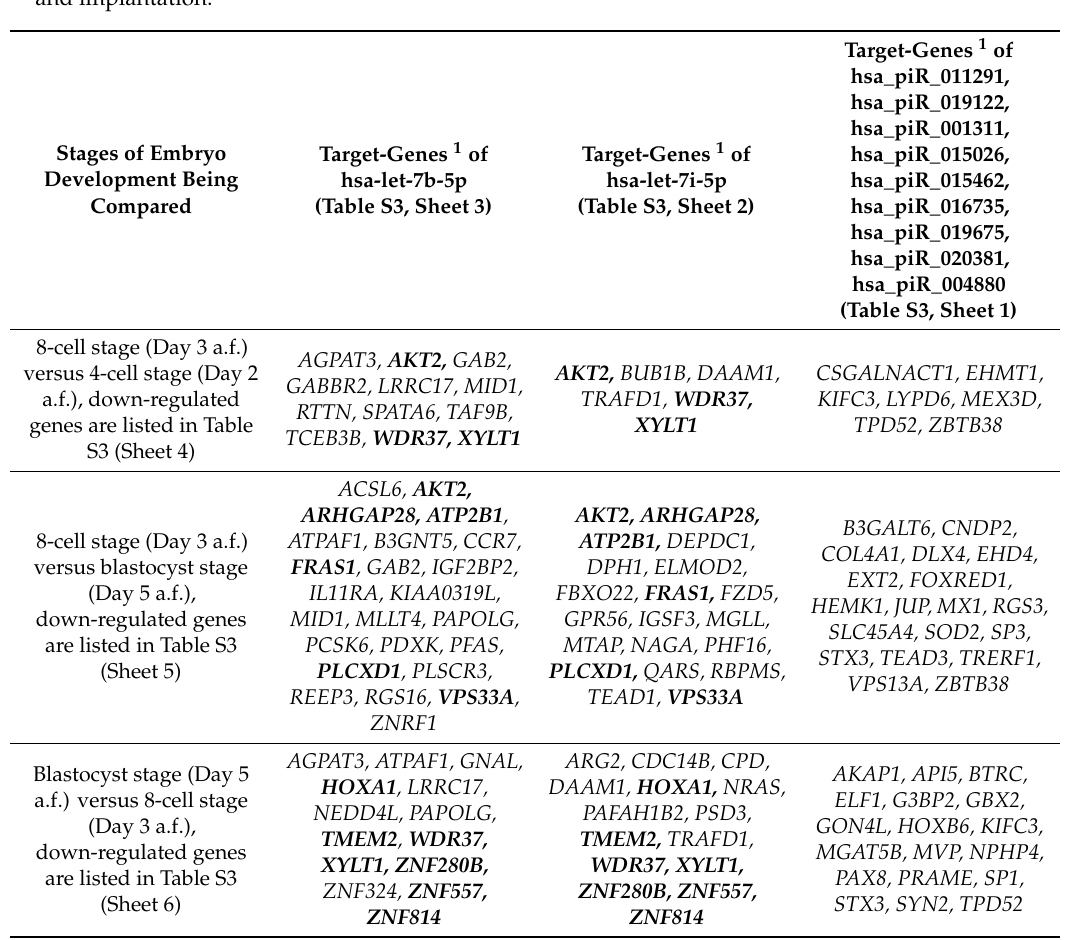
Table 5. Lists of genes with decreased expression level during MZT and blastulation which are possible targets of sncRNAs upregulated in the morula group (group I) with high potential for blastulation and